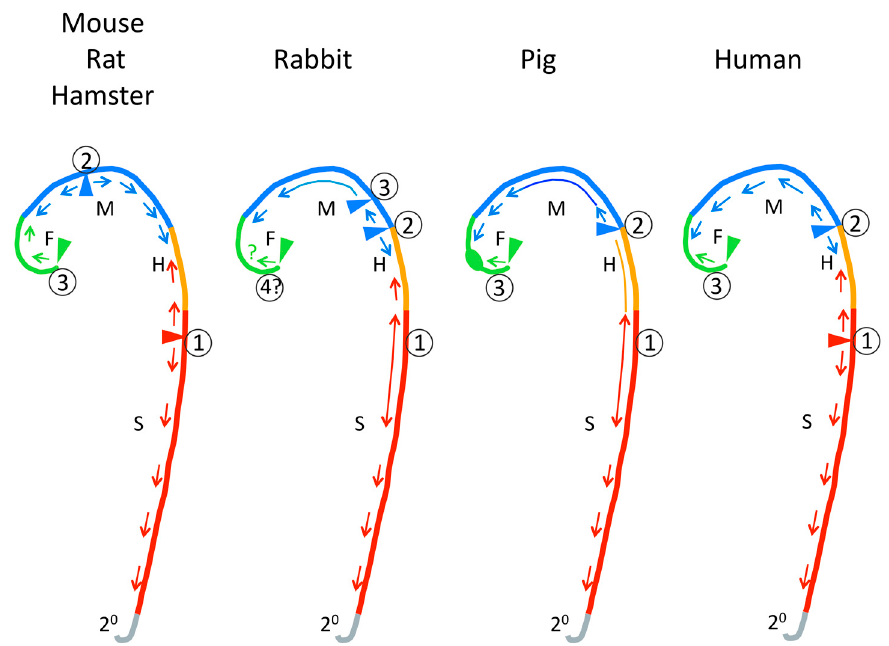
Figure 3. An interpretation of the patterns of neural tube closure in various mammalian species based on published images and studies. Colors denote future anterior–posterior fates of the neural tube. F, forebrain; M, midbrain; H, hindbrain; S, spine. Short arrows indicate direction of zipping. Long stems on arrows and lines lacking arrowheads denote areas that appose and then fuse simultaneously. Triangles and circled numbers indicate closure initiation sites. The forebrain oblong denotes a region that appears to close from all sides, rather than apposition or zipping. 2°, region of secondary neurulation.